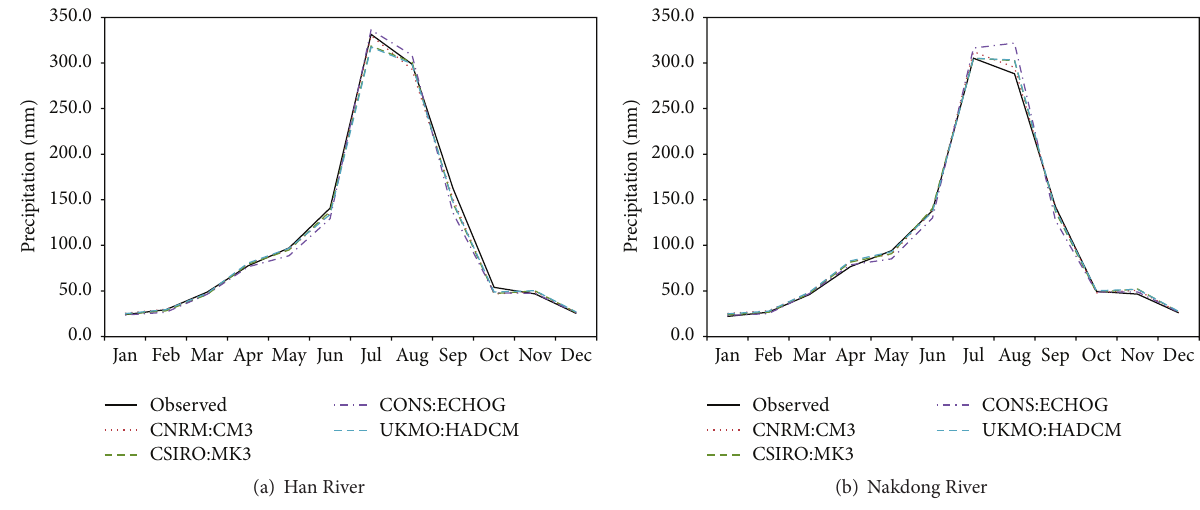
Figure 3: A comparison of the climatological annual cycle between the observed and the simulated data in watersheds of two major rivers for the baseline period